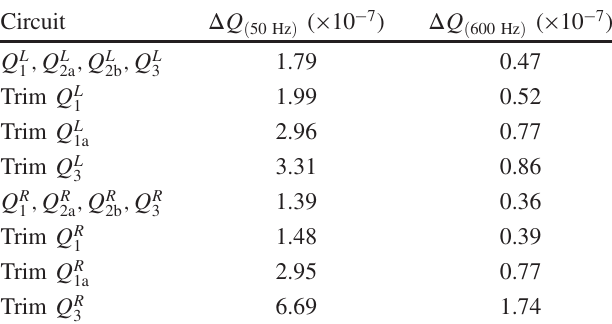
TABLE III. The horizontal and vertical β -functions for the inner triplet quadrupoles left (L1) and right (R1) of IP1 at the end of the luminosity leveling (Table II).